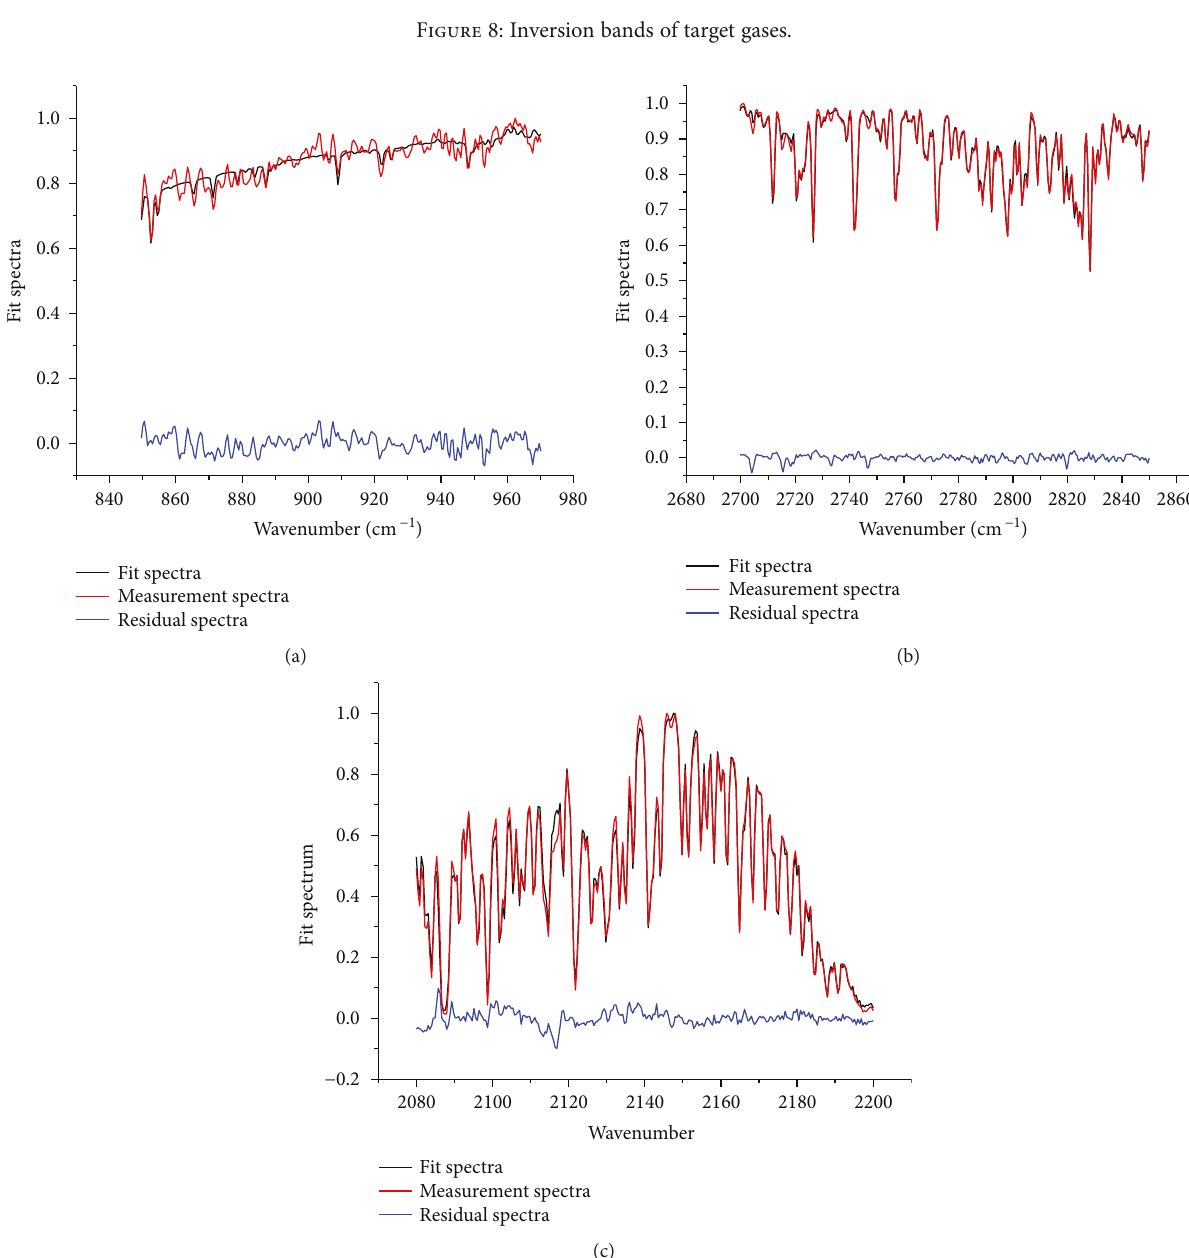
Figure 9: The fi tting result of target gases: (a) the fi tting result of C